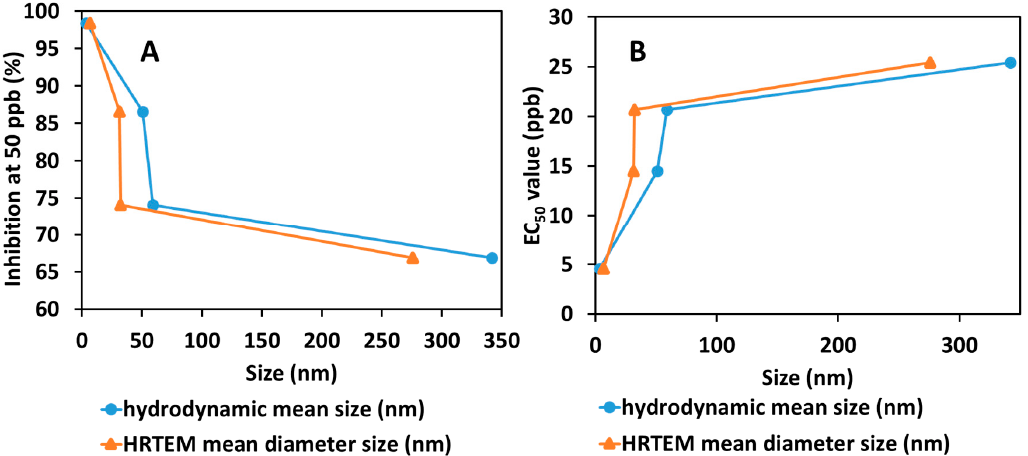
Figure 10. The relationship between the hydrodynamic mean particle size distribution and HRTEM mean particle size distribution of the synthesized chitosan-dazomet nanoparticles to ( A ) their percentage inhibition at 50 ppb and ( B ) the calculated EC 50 (ppb) value on G. boninense .